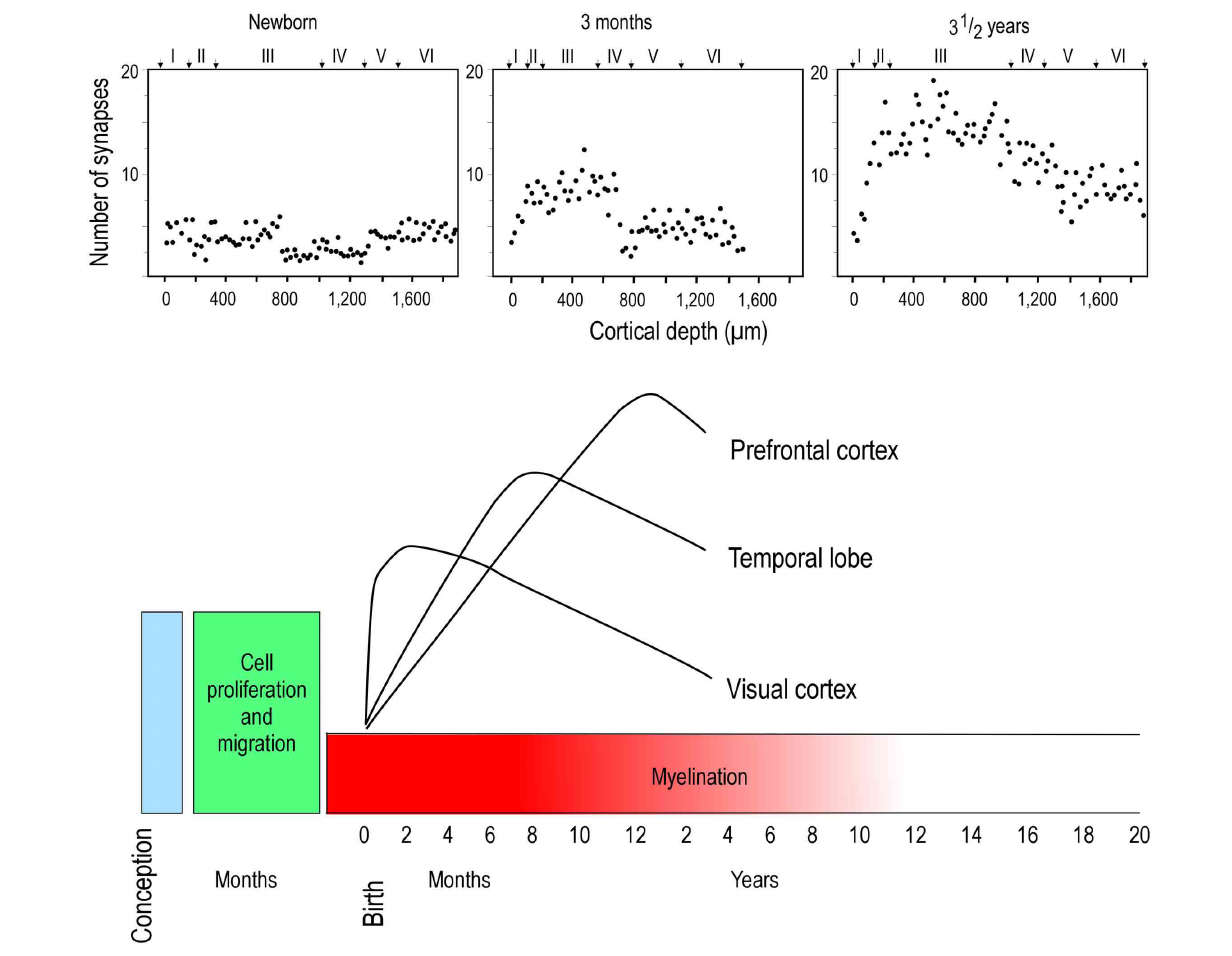
half years of age is greater than that at 3 months of age. Note also the relative differences in synapse densities in the different cortical layers at the different ages illustrated. Modified from Huttenlocher and Dabholkar